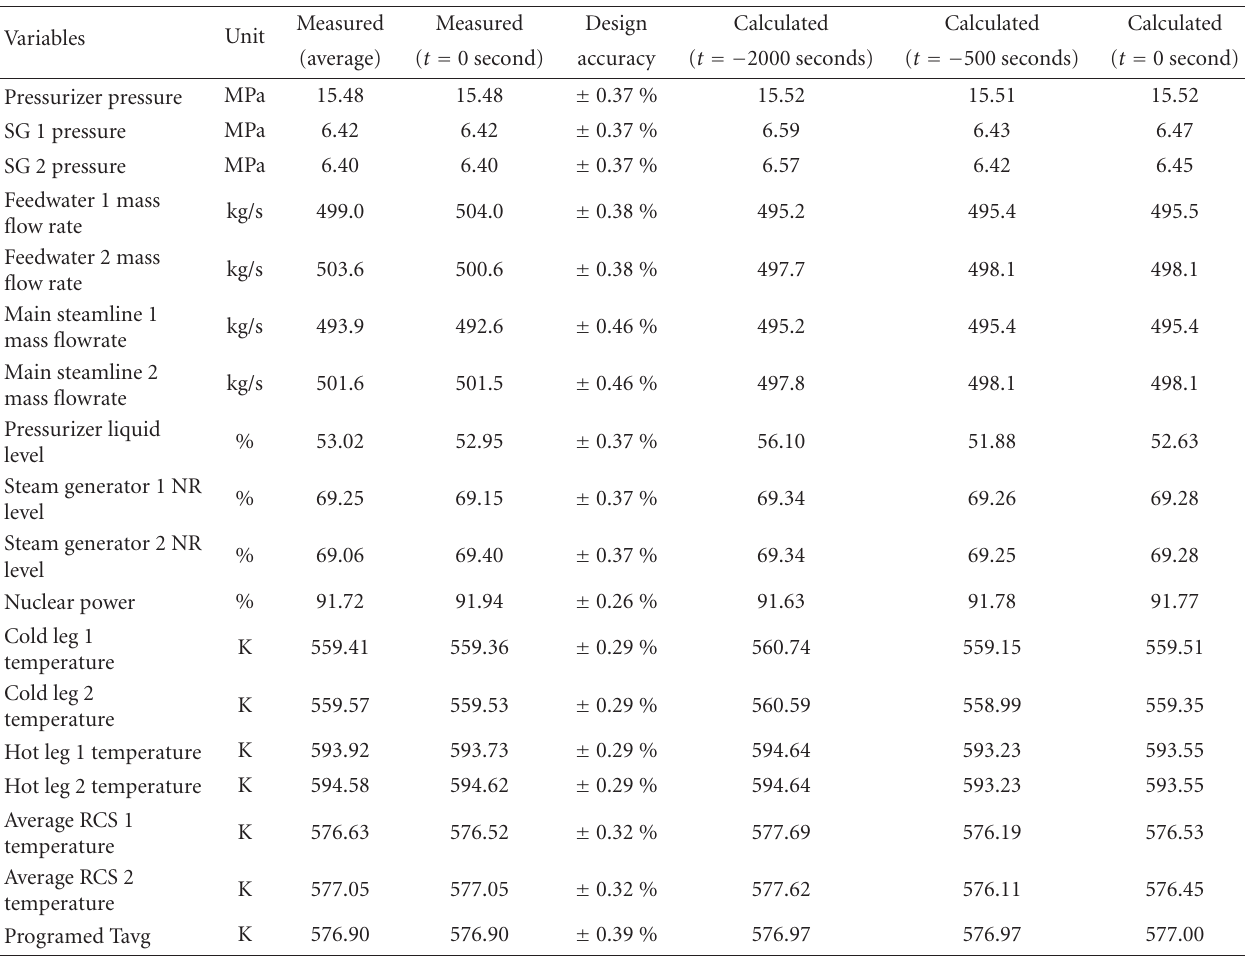
Table 2: Initial conditions for reactor trip